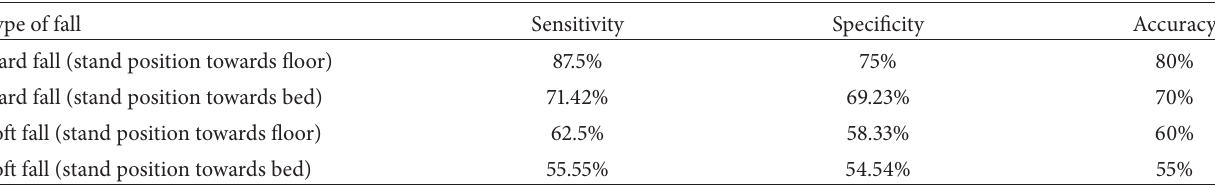
Table 4: Sensitivity, specificity, and accuracy for fall detection